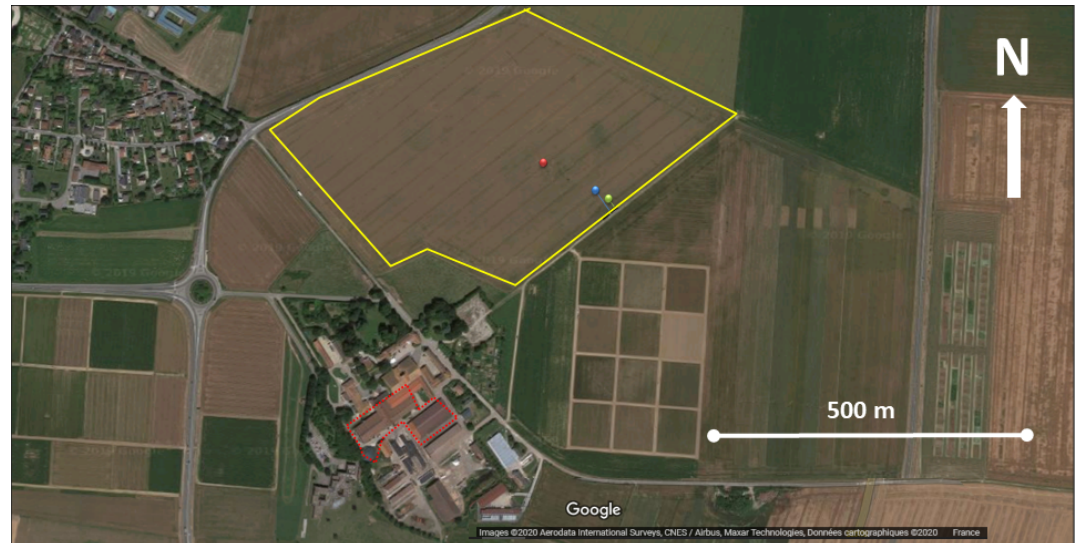
Figure 1. Satellite image of the site showing the ICOS FR-GRI field (yellow line), the ICOS flux station (red dot) the VOC eddy covariance sampling site (blue dot) and the VOC profile sampling site (green dot). The dotted red line shows the farm buildings where animals are mainly stored, on the southeast of the field. © Google Earth.